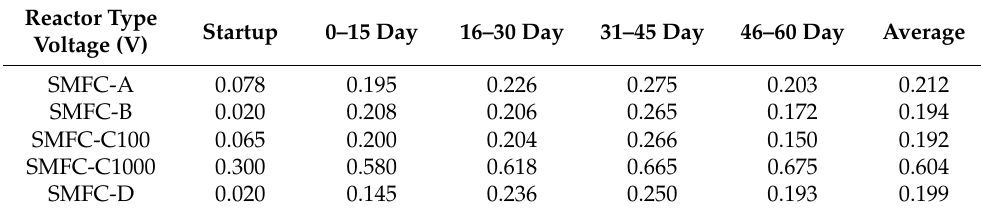
Figure 2. Daily mean voltage curves (1 May to 29 June 2021). Table 2. Average voltages in the experimental groups in different time periods.